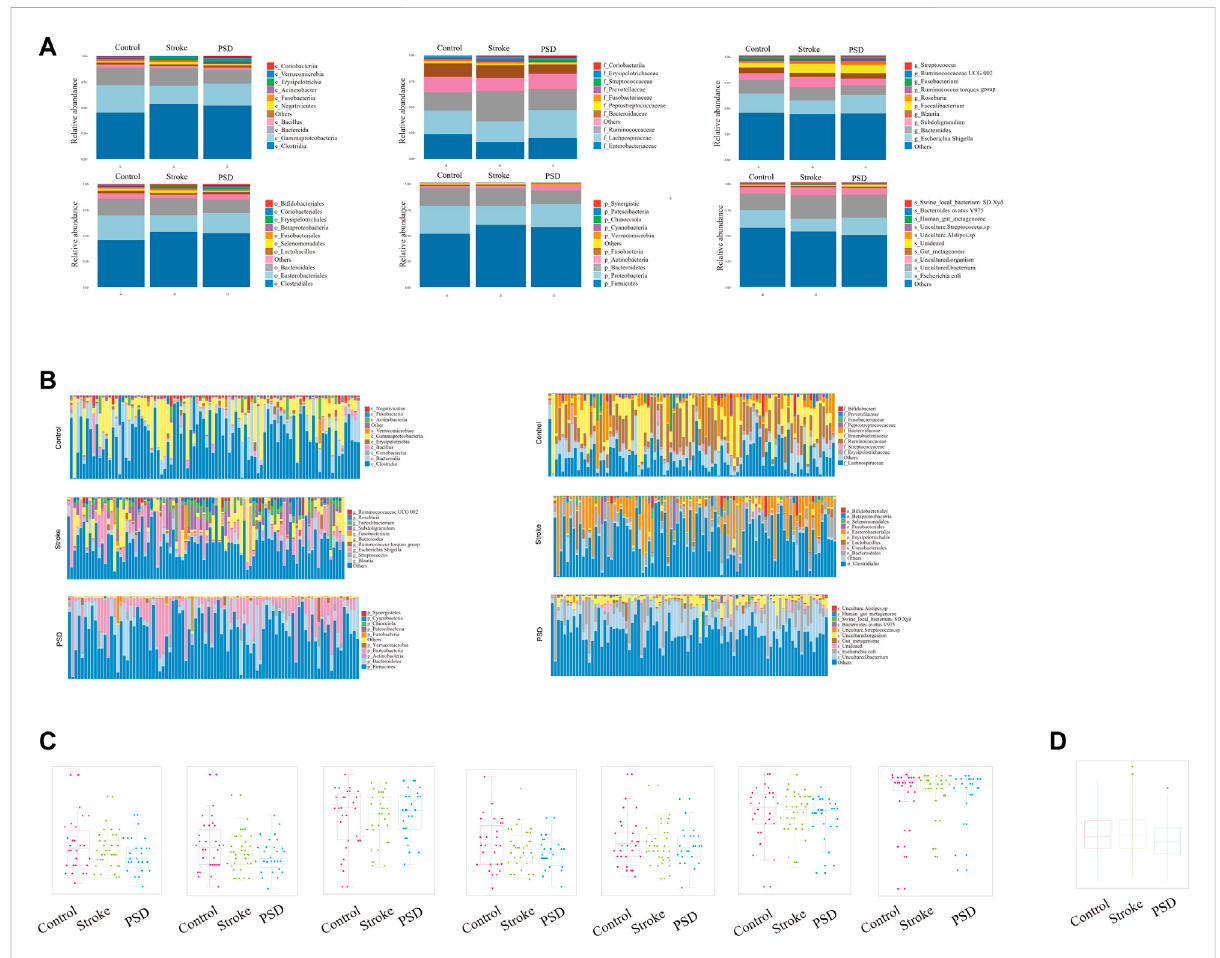
Ecological landscape of gut microbes in Control, stroke and PSD patients. (A) . Histogram of relative abundances of species in each group and classi fi cation level. (B) . Histogram of relative abundances of species in each grouping and classi fi cation level arranged as class, family, genus, order, phylum, and species from left to right and top to bottom. (C) . Box plots of differences in α diversity index between groups (from left to right: alpha diversity, ace index, chao1, good_coverage, observed_species, PD_whole_tree, Shannon, and Simpson index). (D) . Analysis of differences in β - diversity betweengroups basedon weighted Unifrac distance. (E) . Evolutionary clade diagram. (F) .LDA core. (G) . Relative abundancesofbiomarkers in each group of samples. (H) . Results of STAMP